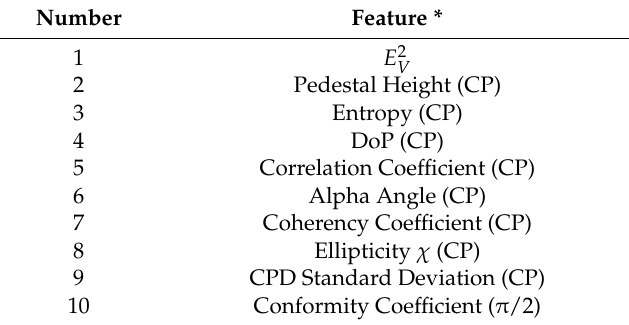
Table 7. Uniform dual and compact polarimetric features considered in the